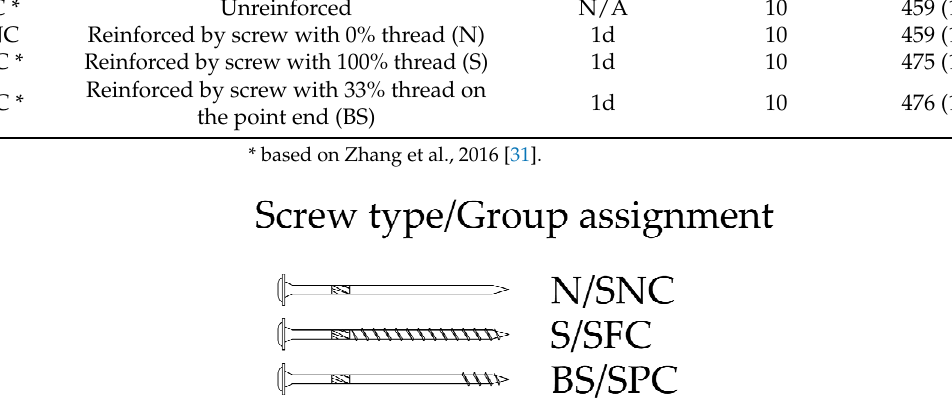
Figure 5. Screw types and corresponding group assignment. Table 2. Summary of groups in the connection tensile test.